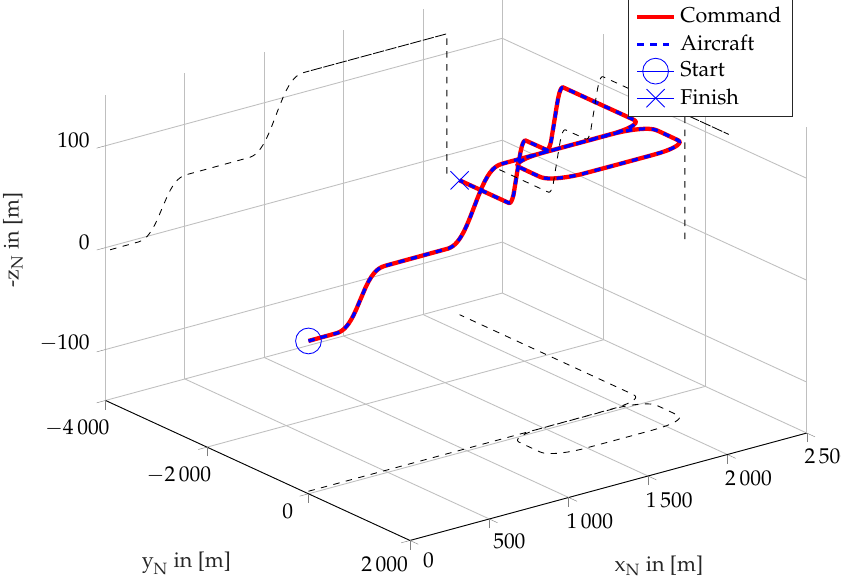
Figure 4. Commanded vs. actually flown trajectory for four-dimensional trajectory control case.